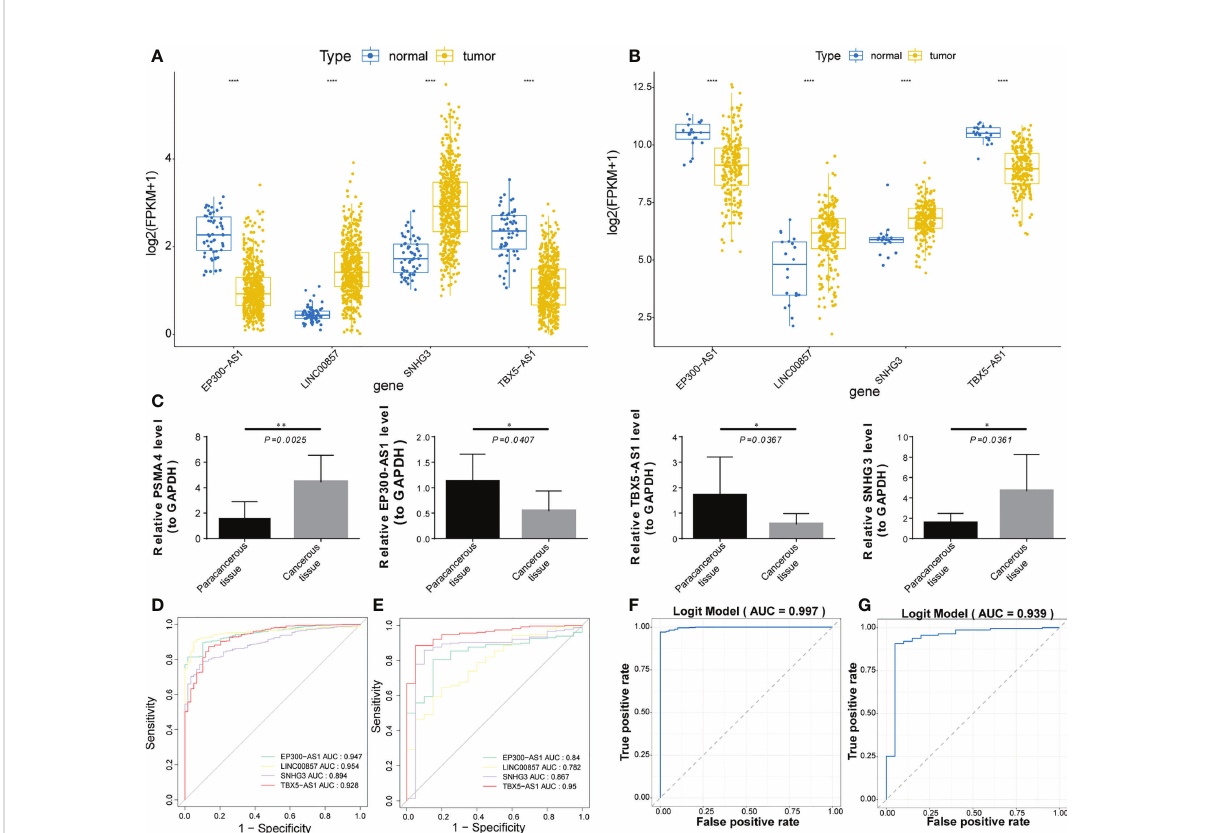
FIGURE 10 Expression validation and diagnostic value analysis of prognostic lncRNAs. (A, B) Boxplot of the expression trends of the four prognostic lncRNAs in 2 datasets. (C) Boxplots of the expression levels of the four lncRNAs between the paracancerous and cancerous tissue samples. (D, E) ROC curve analysis of prognostic lncRNAs diagnostic ability in 2 datasets. (F, G) ROC curve analysis of the overall diagnostic model in 2 datasets. *, **, and **** represent P < 0.05, P < 0.01, and P < 0.0001,